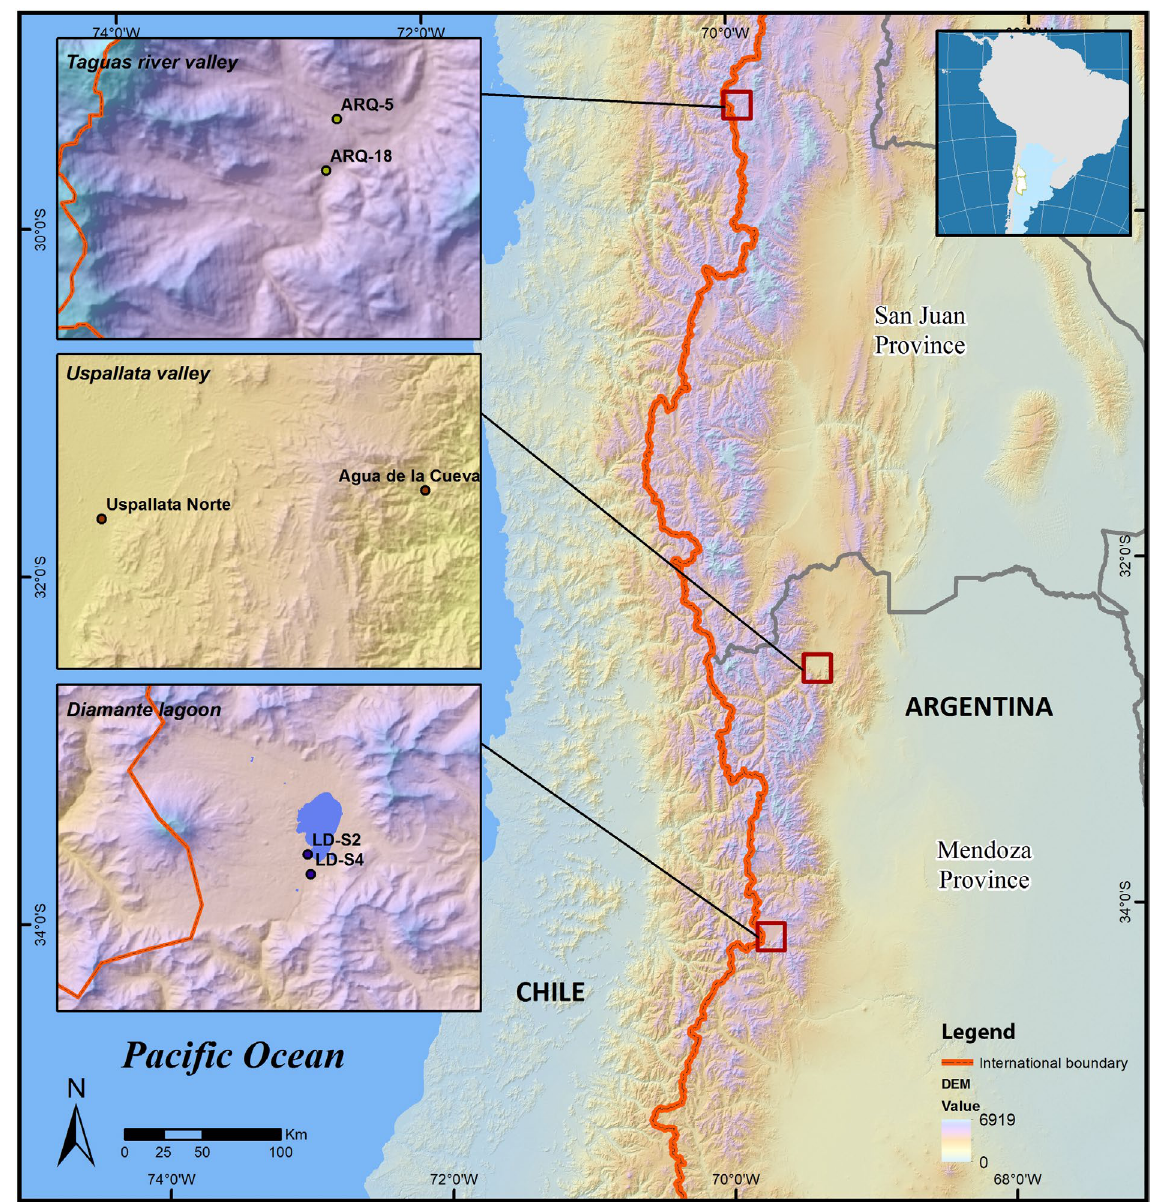
Figure 1. Study area and archaeological